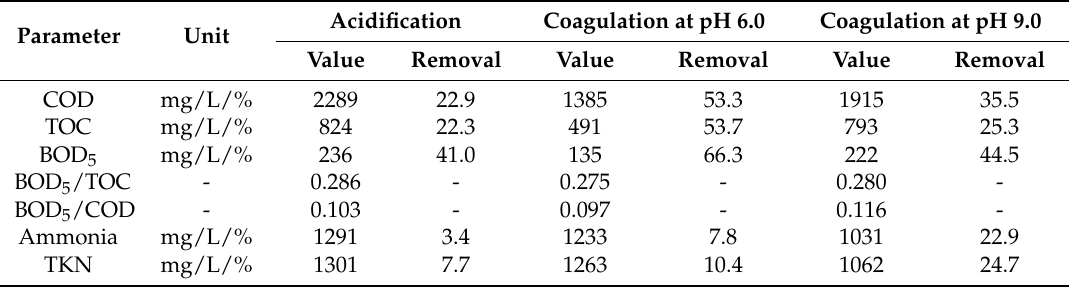
Table 2. Landfill leachates pretreatment